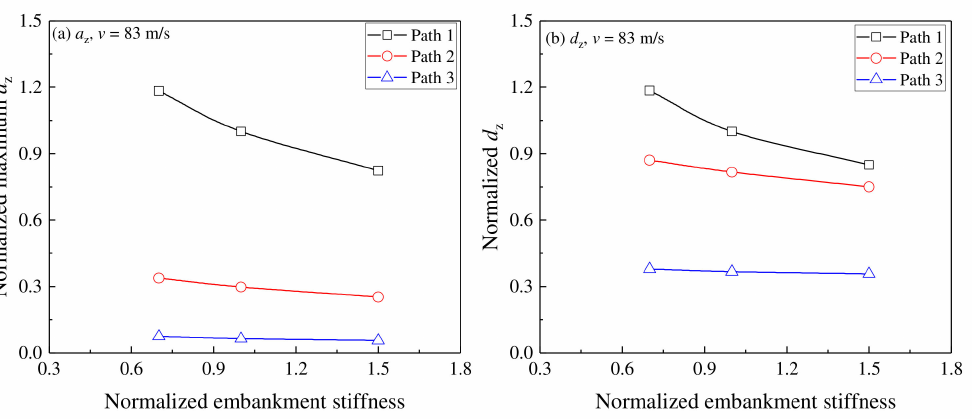
Figure 16. Relationship between normalized maximum a z , d z and normalized embankment stiffness in different paths: ( a ) normalized maximum a z ; ( b ) normalized maximum d z